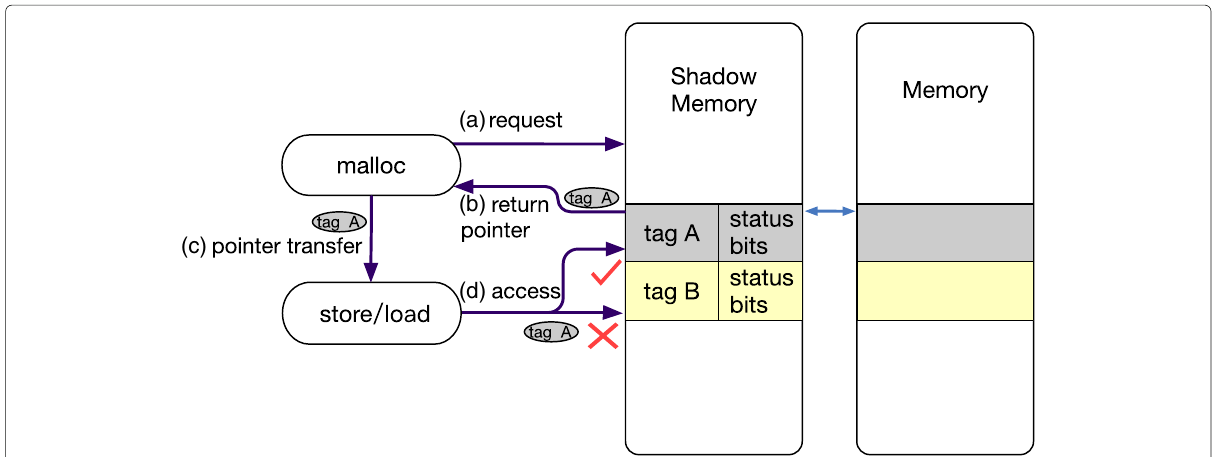
Fig. 3 Illustration of heap-based vulnerability identification. Each heap object and pointer is associated with a memory tag. An extra status is attached to each memory